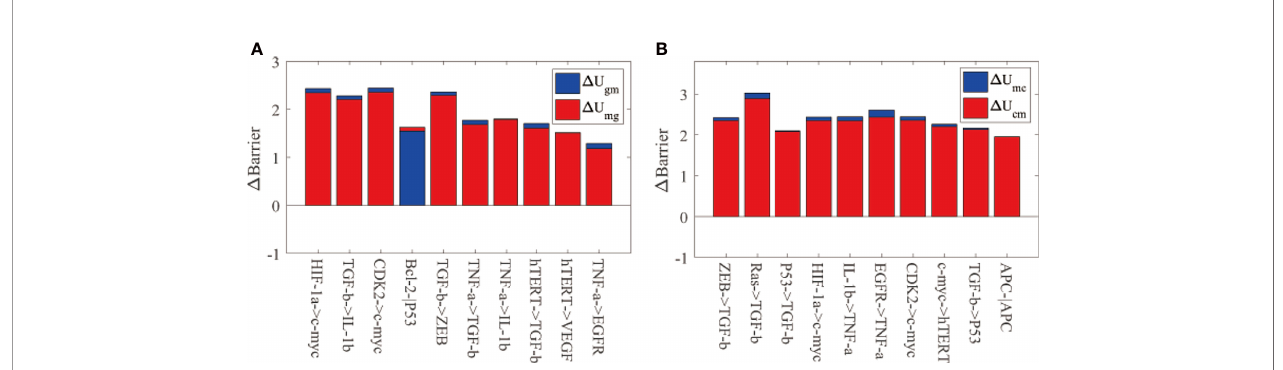
FIGURE 5 | The global sensitivity analysis for IGC with Helicobacter pylori infection. The meanings of the X-axis and Y-axis are the same as Figure 3 . (A) The barrier height variations between the AG and IM states. Δ Ugm represents the barrier height variation between the AG and IM states. Δ Umg is the barrier height variation between the IM and AG states. (B) The barrier height variation between the IM and cancer states. Δ Umc is the barrier height variation between the IM and cancer states. Δ Ucm is the barrier height variation between the cancer and